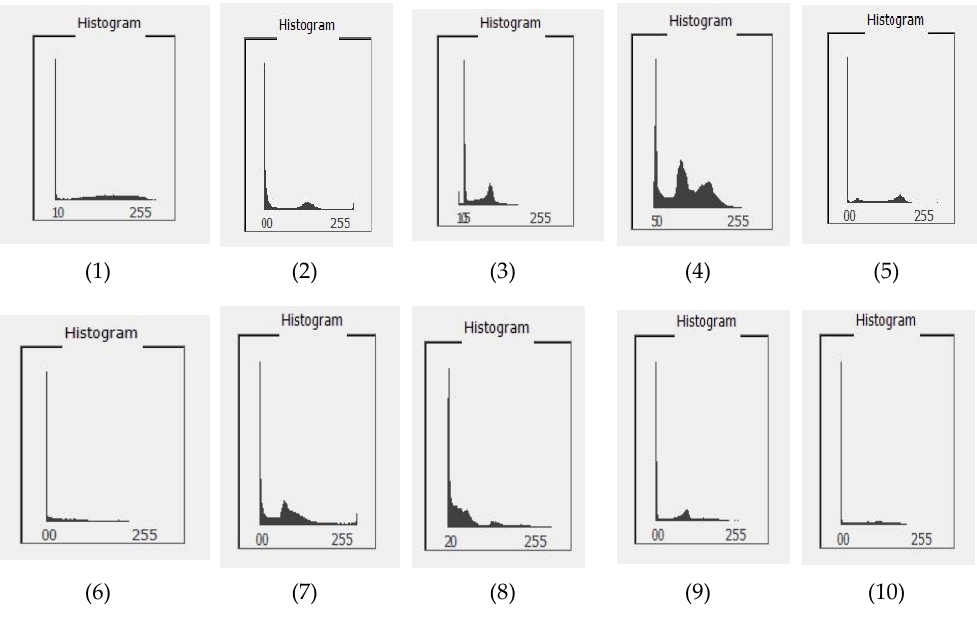
Figure 3. Histograms of the images in Figure 2.